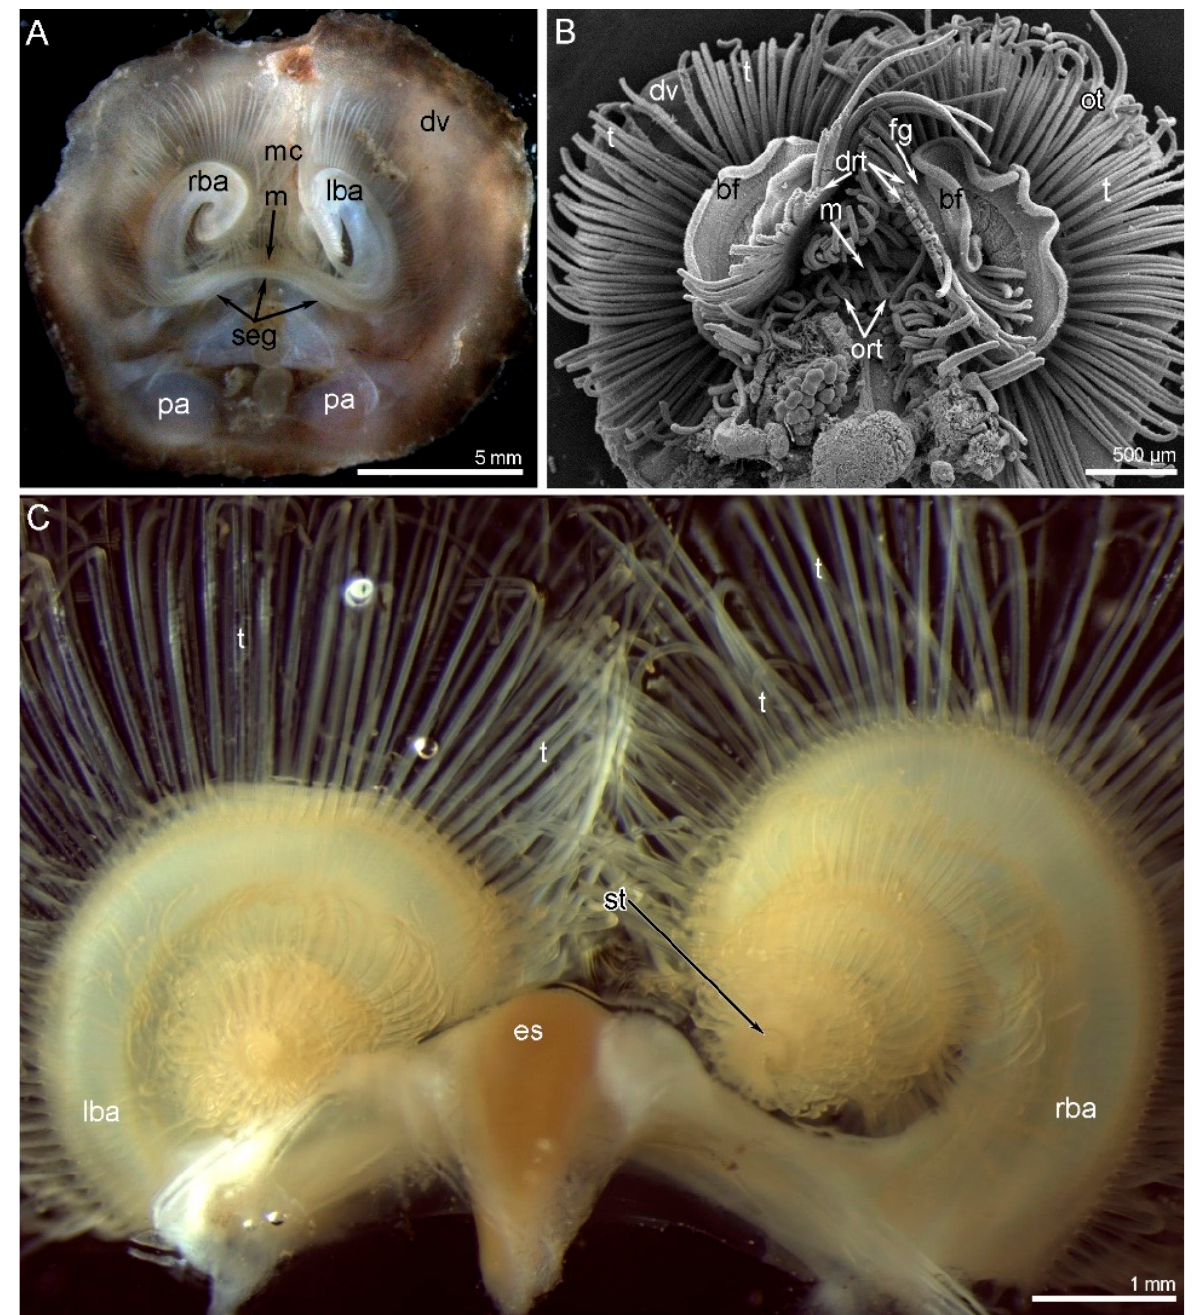
Figure 1. Organization of the lophophore in Novocrania anomala adults. ( A ) Photograph of a live animal viewed from the ventral side. ( B ) The same animal; SEM. ( C ) Photograph of separated spirolophe viewed from the dorsal side. The zones where new tentacles form are located on the distal end of each brachial arm. Abbreviations: bf—brachial fold; drt—double row of tentacles; dv—dorsal valve of the shell; es—esophagus; fg—food groove; lba—left brachial arm; m—mouth; mc—mantle cavity; ort—oral tentacles; ot—outer tentacle; pa—posterior adductor; rba—right brachial arm; seg—subenteric ganglion; st—zone of youngest tentacle; t—tentacle.